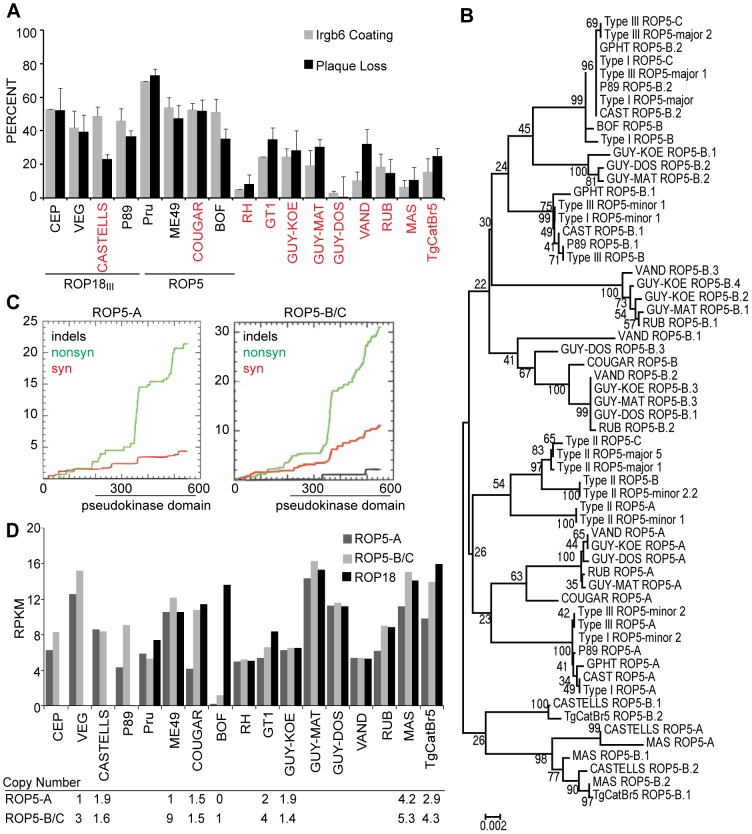
ROP5-A, ROP5-B/C and ROP18 account for strain differences in IRG evasion in non-canonical strains.(A)Quantification of percentage of PVs with Irgb6 localization and percentage plaque loss on IFNγ-stimulated MEFs compared to unstimulated MEFs infected with the indicated strains. Strains that have greater than 90% mortality in CD-1 outbred mice [11] are indicated in red. The predicted reason for high IRG coating is indicated below the graph, which for CEP, VEG, CASTELLS and P89 is the unexpressed ROP18III allele, and for Pru, ME49, COUGAR and BOF is divergent or missing ROP5 alleles. (B) Phylogenetic tree of ROP5-A, B andC and previously reported major and minor alleles [34] constructed from full-length coding nucleotide sequences using Neighbor-Joining with 1000 bootstraps. (C) Cumulative behavior, codon by codon, of synonymous (red), nonsynonymous (green) and insertion/deletion (black) mutations in ROP5-A (left) and ROP5-B/C (right). (D) Relative expression of ROP5-A, ROP5-B/C and ROP18 determined by RNA-Seq of murine BMDM infected for 24 hours with the indicated strains. Samples were matched for similar levels of Toxoplasma RNA. ROP5-A and B/C copy number estimated by sequencing coverage of the ROP5 locus versus the average genome coverage for strains for which the genome has been sequenced is indicated in the table below the graph.